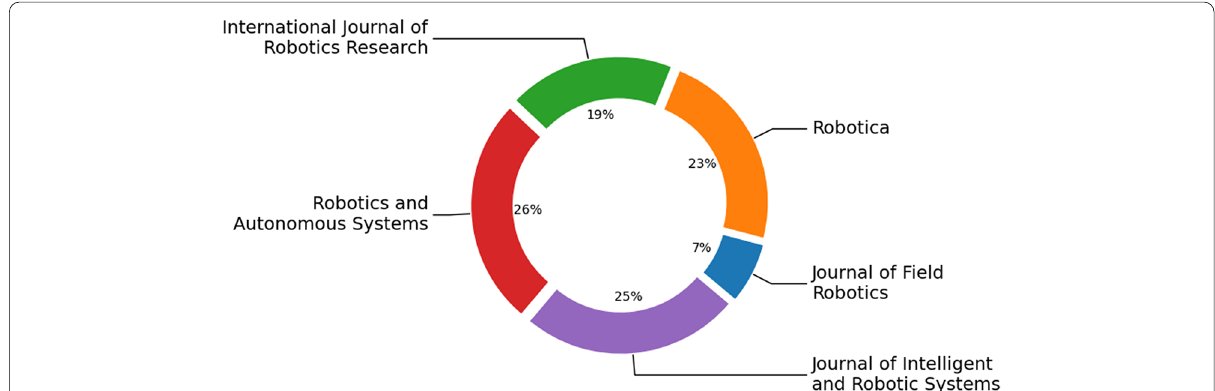
Table 8 Top 15 institutions contributed to RR along with WOS report metrics for the Robotics research area (1991–2020)